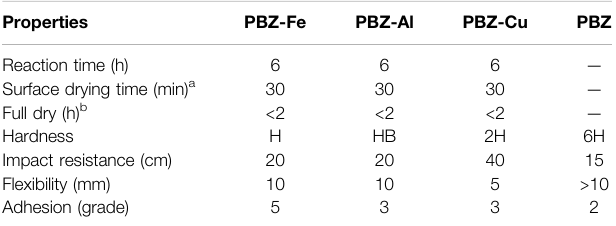
TABLE 4 | The comparison of the mechanical properties of PBZ-Cu, PBZ-Al, PBZ-Fe, and PBZ. Properties